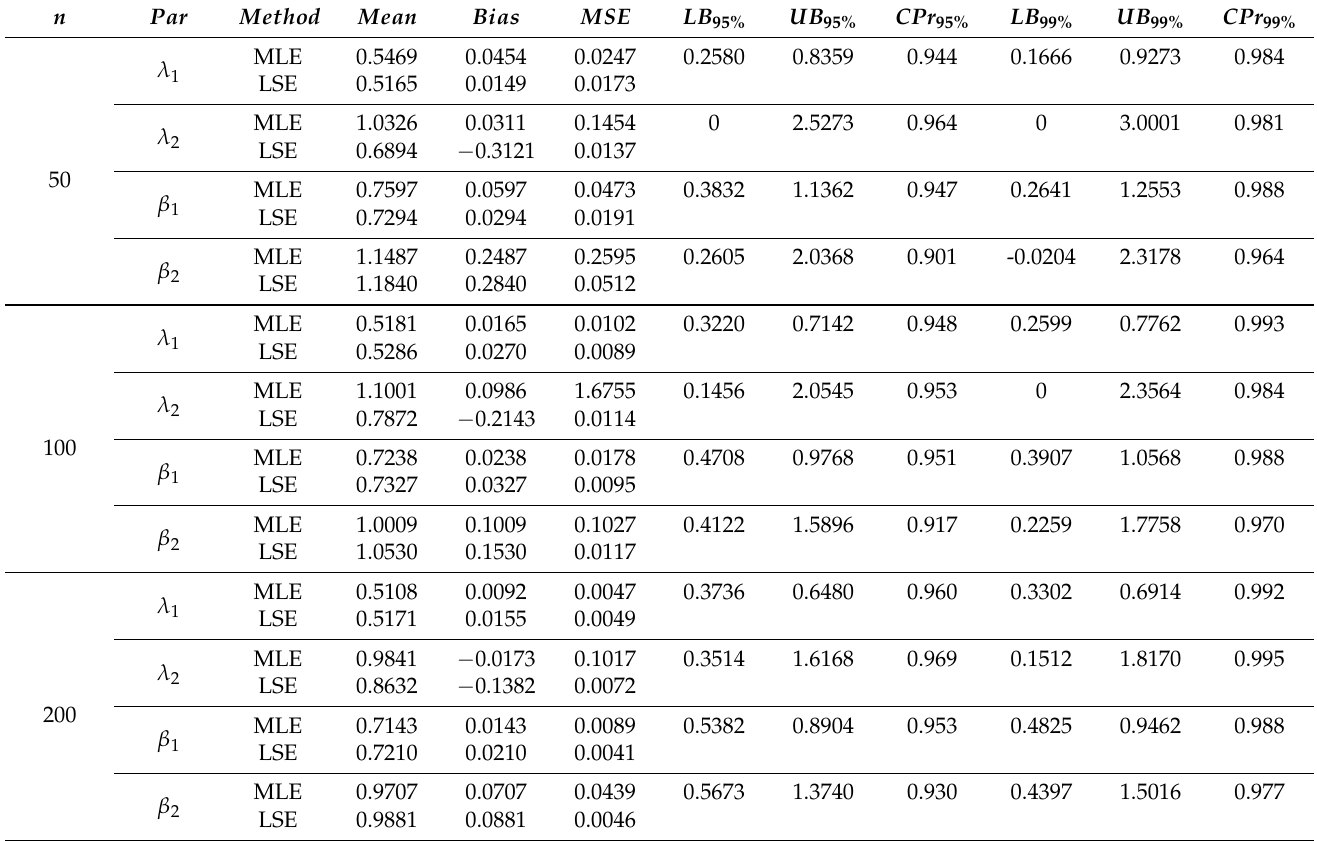
Table 1. The results of MLEs, LSEs, interval estimates, and CPrs when β 1 = 0.7, β 2 = 0.9, λ 1 =